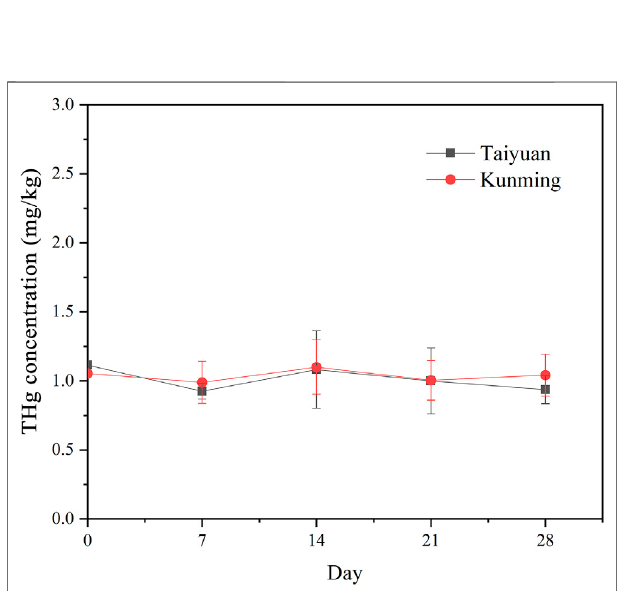
FIGURE 5 | Total Hg concentrations (mg/kg, dry weight) in selected sewage sludge samples during the ventilation test.